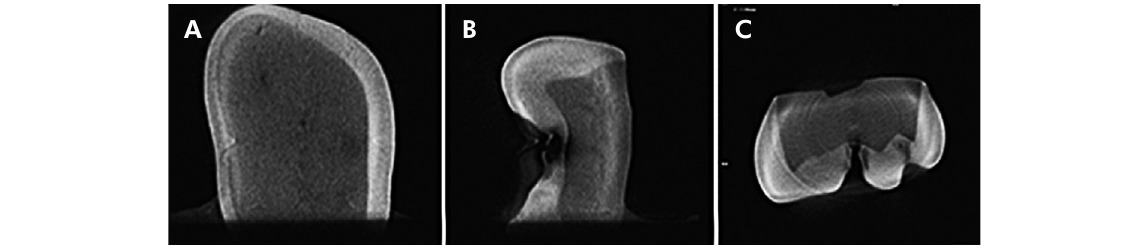
Figure 2. Axial (A), sagittal (B), and coronal (C) images of